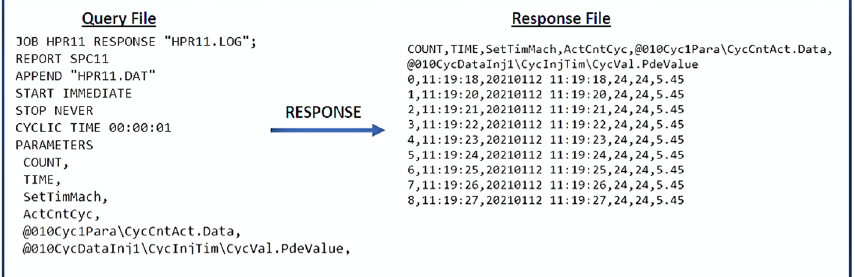
Fig. 3 A sample of file transfer via Euromap 63, that is plastic injection molding machines specific